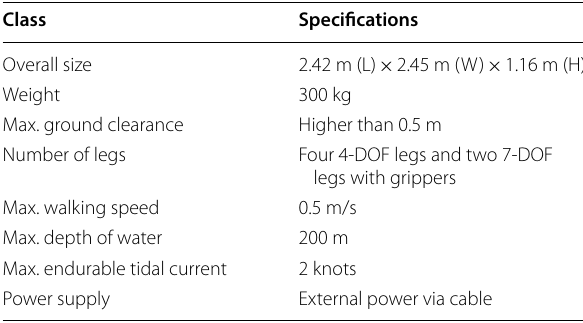
Table 4 Specifications of CR200 [32,